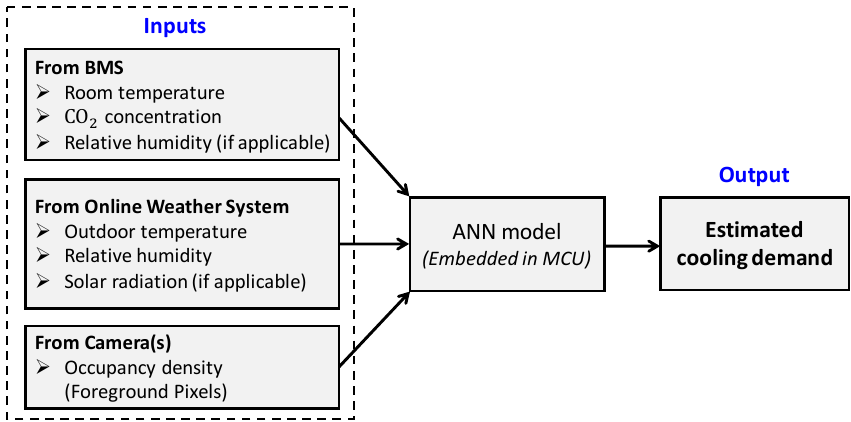
Figure 1. Block diagram of the proposed load estimation scheme.